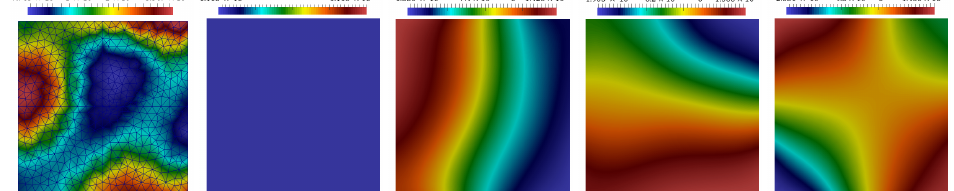
Figure 2. An example of the first four eigenvectors for pressure in a local domain ω l without fractures in a heterogeneous local domain.